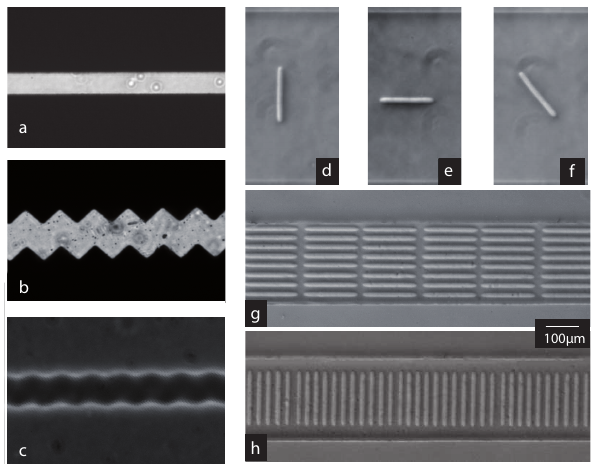
Figure 3. Examples of photopolymerized fibers. Left panel: ( a ) example of the mask used to fabricate the fibers. The mask shown here is smooth and will allow the fabrication of smooth fibers like the ones shown in the top row of the right panel; ( b , c ) the surface roughness of the fiber can be increased by drawing its borders with saw-tooth lines instead of straight ones (( b ) mask; ( c ) resulting fiber). Right panel: top, isolated fibers ( d – f ); and suspensions of fibers ( g , h ) fabricated at varying initial orientation. A movie showing the fabrication of the parallel fiber suspension is available in Supplementary Materials Video